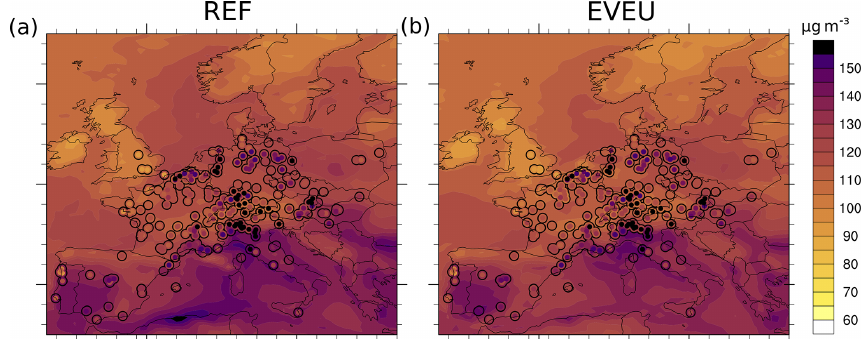
Figure 2. 95th percentile of ozone (in µgm − 3 ) for the period JJA 2008 to 2010 as simulated by REF (a) and EVEU (b) . The background colours show the ozone concentrations as simulated by CM50, and the circles represent the location of stations of the Airbase v8 observation data. The inner point represents the measured concentrations and the outer point the concentrations in the respective grid box, where the station is located. All values are based on data every 3h.